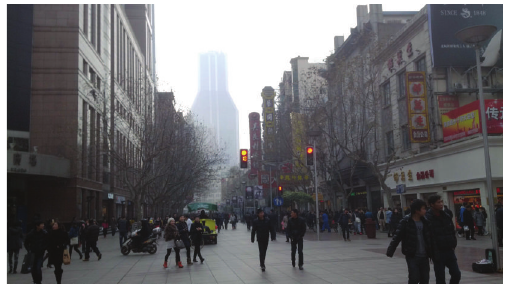
Figure 2: A photograph of the Nanjing